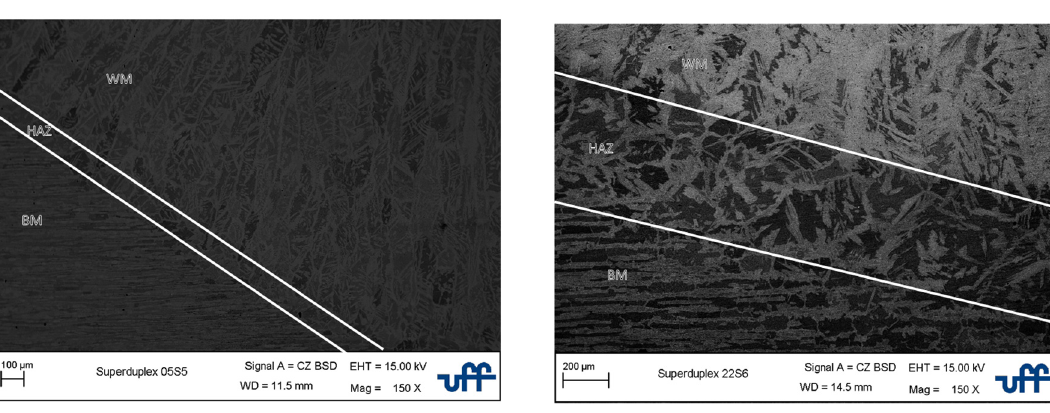
Figure 14. SEM image of the welding regions for heat input of 0.5 kJ mm -1 .